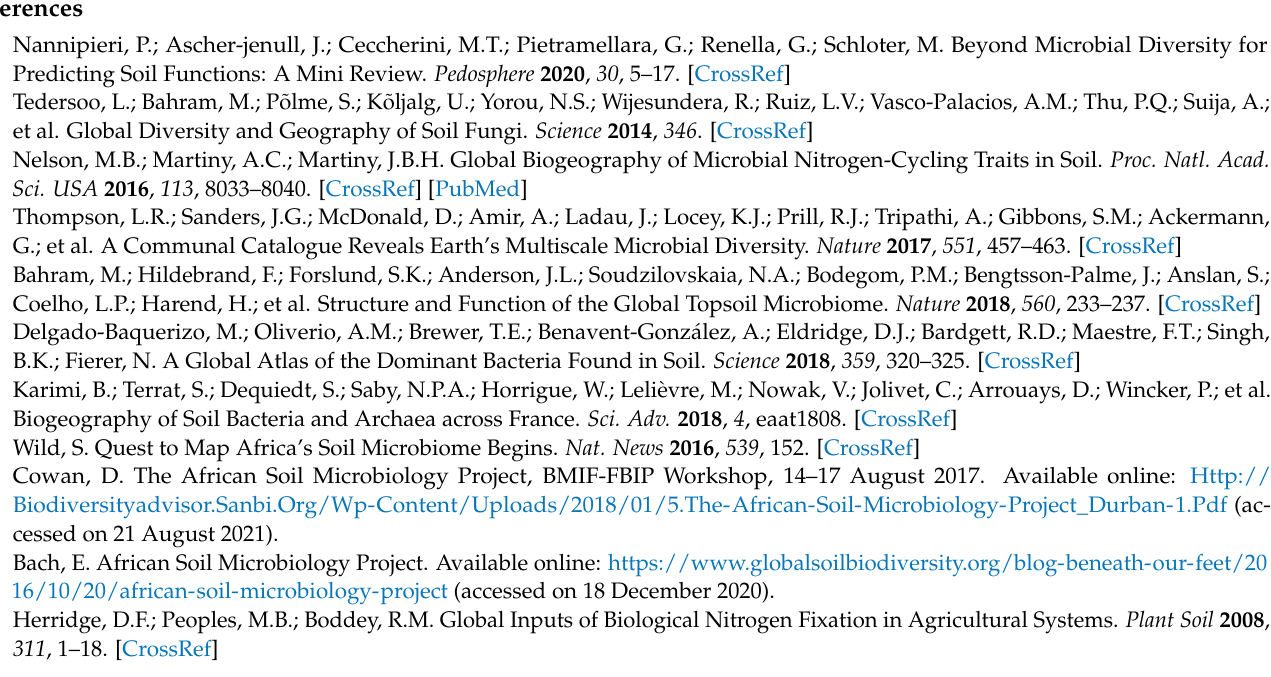
10.3390/microorganisms9091842/s1, Figure S1: Covering area of each sampling site and its corre- sponding features, Figure S2: Rarefaction curve of the seven samples, indicated by the number of ASVs depending on the size of the sequence sample, Figure S3: 16S rDNA V4-V5 phylogenetic tree showing the relationship between all selected reference alpha and beta-rhizobia strains and the 77 ASVs detected in savannah soils of Northern C ô te d’Ivoire, Table S1: Physico-chemical properties of samples soils, Table S2: Levels of similarity between the V4-V5 sequences of the 77 ASVs of rhizobia and all 18 alphaproteobacterial and betaproteobacterial genera harboring rhizobia strains, Table S3: Major characteristics of the 77 ASVs of rhizobia detected in savannah soils of Northern C ô te d’Ivoire, Table S4: ASVs and their corresponding md5_hash identities, Table S5: ASVs richness, cumulative relative abundance of sequences and prevalence of ASVs per soil, Table S6: Measure of the richness and the alpha diversity per savannah